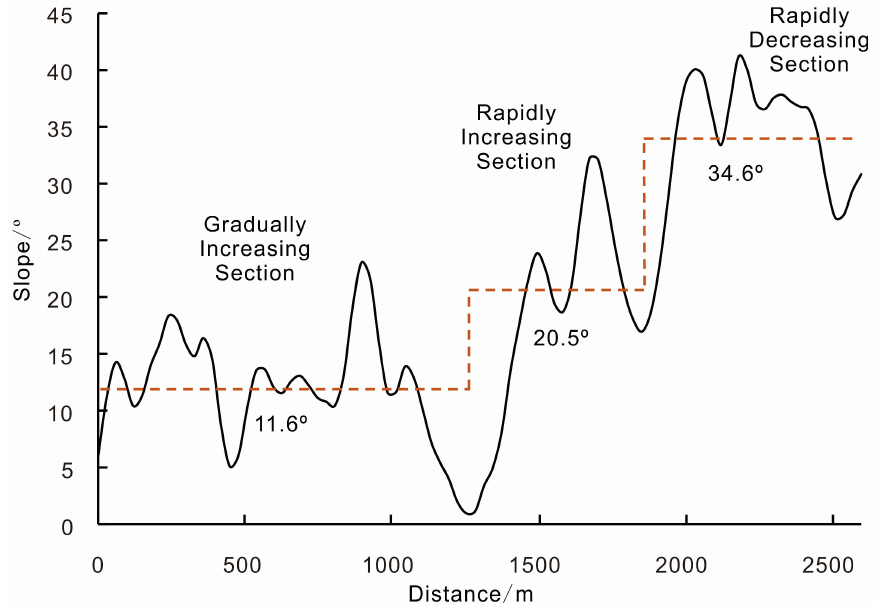
Figure 12. Mean slope and velocity trends on 1-1’ profile line. The black curve stands for the slope values along the profile line 1-1’, while the yellow dashed line depicts the average slope levels on different sections of the profile line.